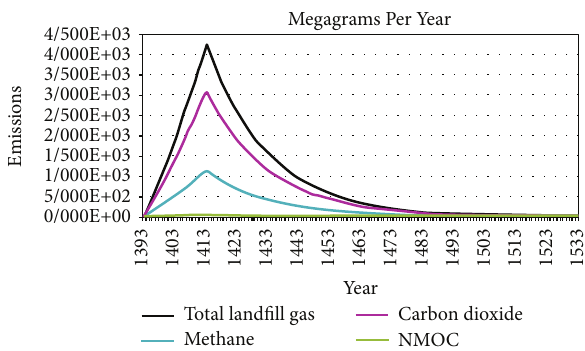
Figure 4: Methane emission curve in mg per year.